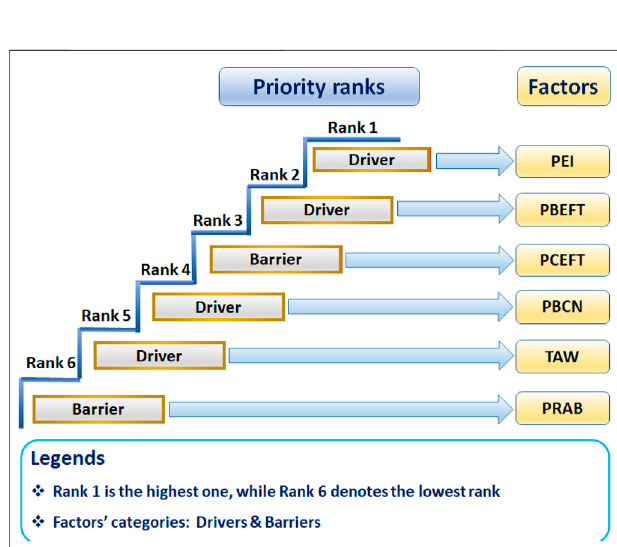
FIGURE4| Prioritizationranksoffactorsaffectinghouseholds ’ adoption intention of EFTs. Source: Prioritization is based on f -square scores of the structural